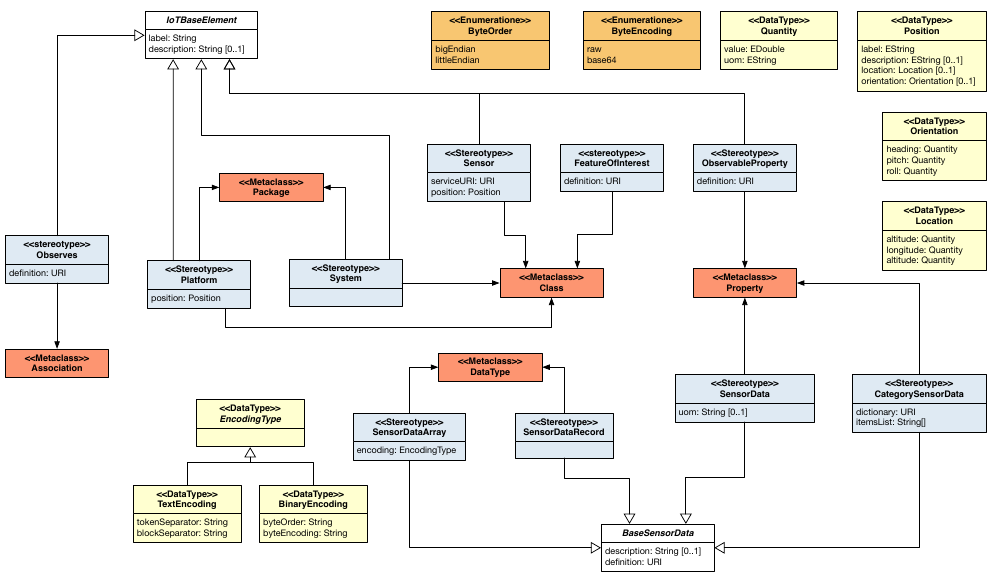
Figure 4. SysML profile for